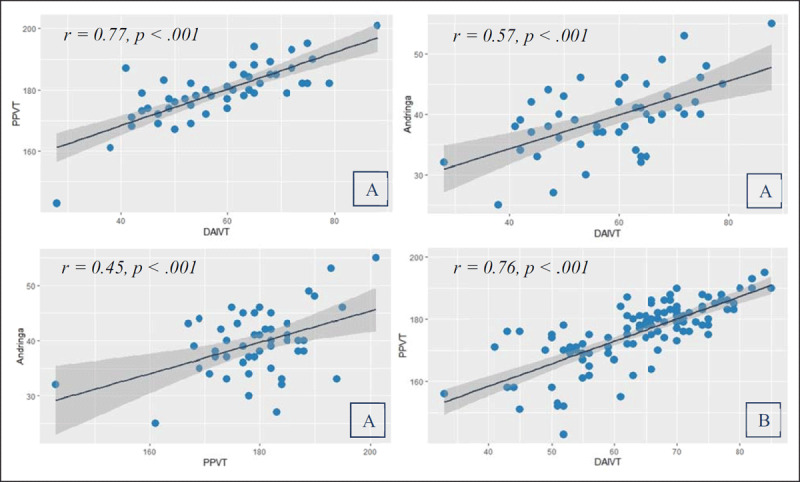
Correlations (and regression lines with 95% confidence interval) between the DAIVT (90 items), the PPVT-III-NL, and Andringa et al.’s test; A 49 first year psychology students, B 108 MPI participants (ages 18–26).